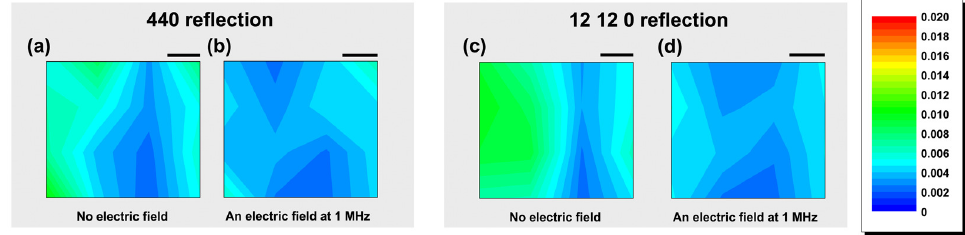
Figure 3. Representative two-dimensional maps of FWHMs measured for the 440 and 12 12 0 reflections from tetragonal HEW lysozyme crystals prepared ( a , c ) with and ( b , d ) without an external electric field at 1 MHz. The upper-right scale bar for each two-dimensional map represents 0.3 mm. Reproduced from reference [19], with the permission of AIP